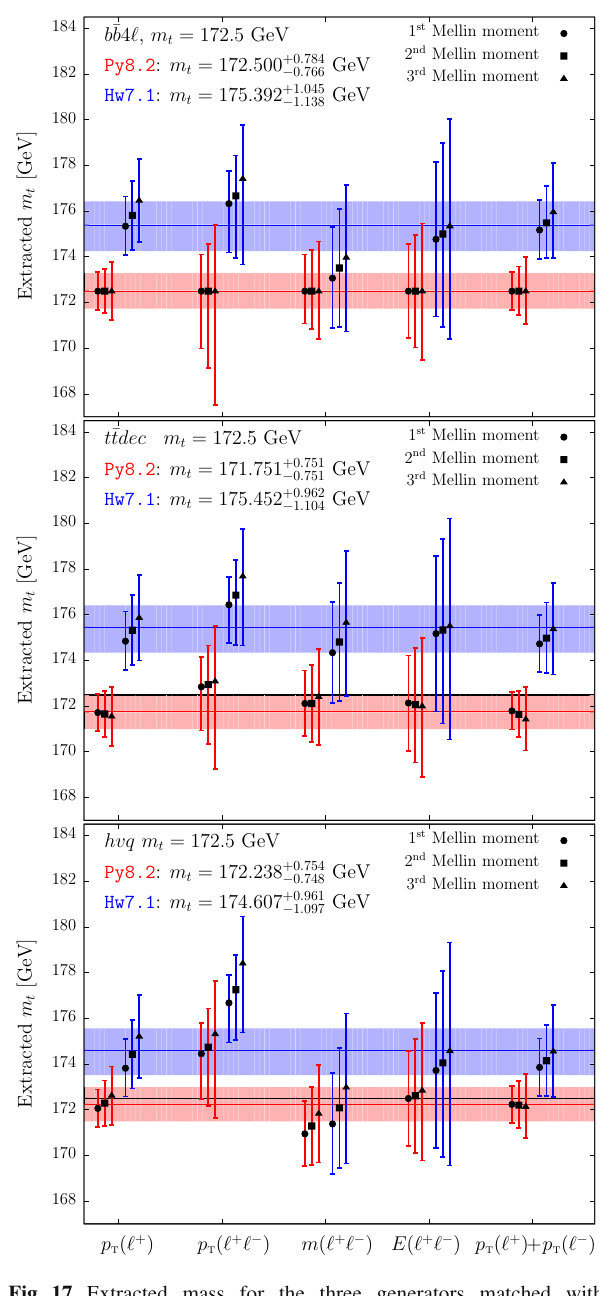
Fig. 17 Extracted mass for the three generators matched with Pythia8.2 (red) and Herwig7.1 (blue) using the first three Mellin moments of the five leptonic observables. The horizontal band repre- sents the weighted average of the results, and the black horizontal line corresponds to m t = 172 . 5 GeV, which is the top mass value used in the b ¯ b 4 (cid:4) + Pythia8.2 reference